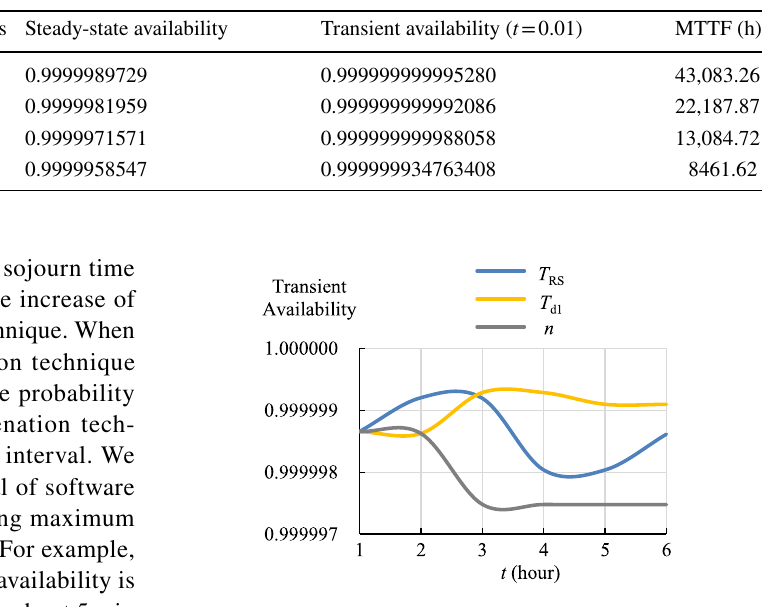
Fig. 9 Effect of time-varying parameters on transient